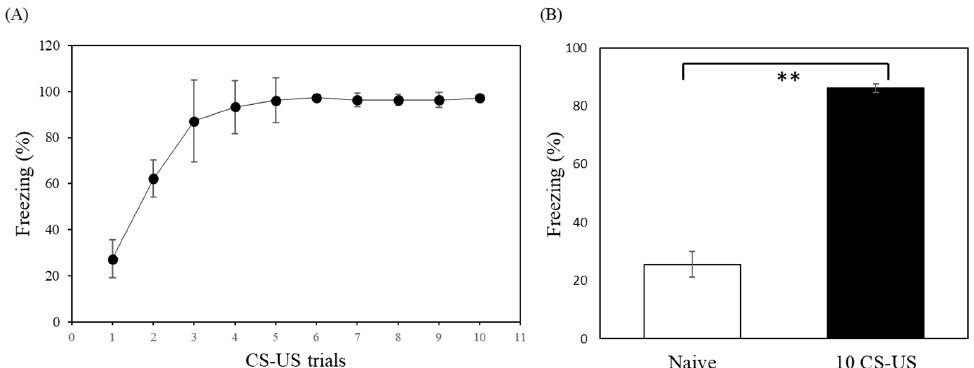
Figure 2. Analysis of freezing behavior in fear-conditioned and control rats. ( A ) The effect of the number of CS-US pairings. Fear-conditioned rats received 1–10 tone-foot-shock training, consisting of a 20 s tone (CS) of 80 dB, and a foot-shock of 1.2 mA (US) administered for 3 s. This study observed that increasing the number of CS-US pairings caused the animals to exhibit a higher freezing response. ( B ) The rats which received 10 CS-US presentations froze significantly more than control animals. The control group (Naive) showed without freezing than CS-US group presentated. Data points represent the mean values, and the error bars represent standard deviations. **, p < 0.001 ( t - test).